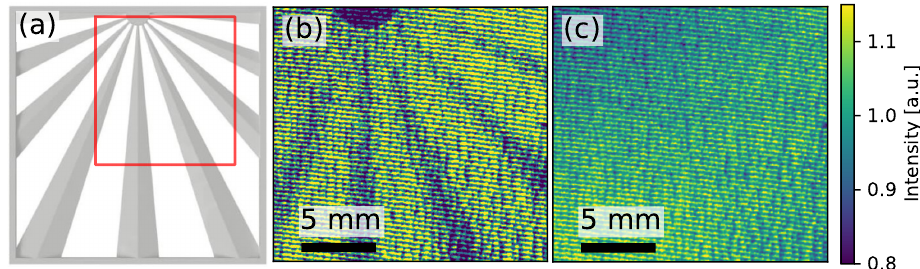
Figure 1. ( a ) 3D rendering of the used sample. The shading within one branch indicates an increasing, decreasing thickness, respectively. The frame and the semicircle on the upper frame have a constant thickness. Its overall dimension is 42.5 × 42.5 mm and was made of a polyacrylic mixture using stereolithography. The red frame marks the area which is presented in this work. The images ( b , c ) show a section of the object image and reference image number one. The Moiré stripes are tilted slightly clockwise from the horizontal axis. The scale indicates the size in the detector